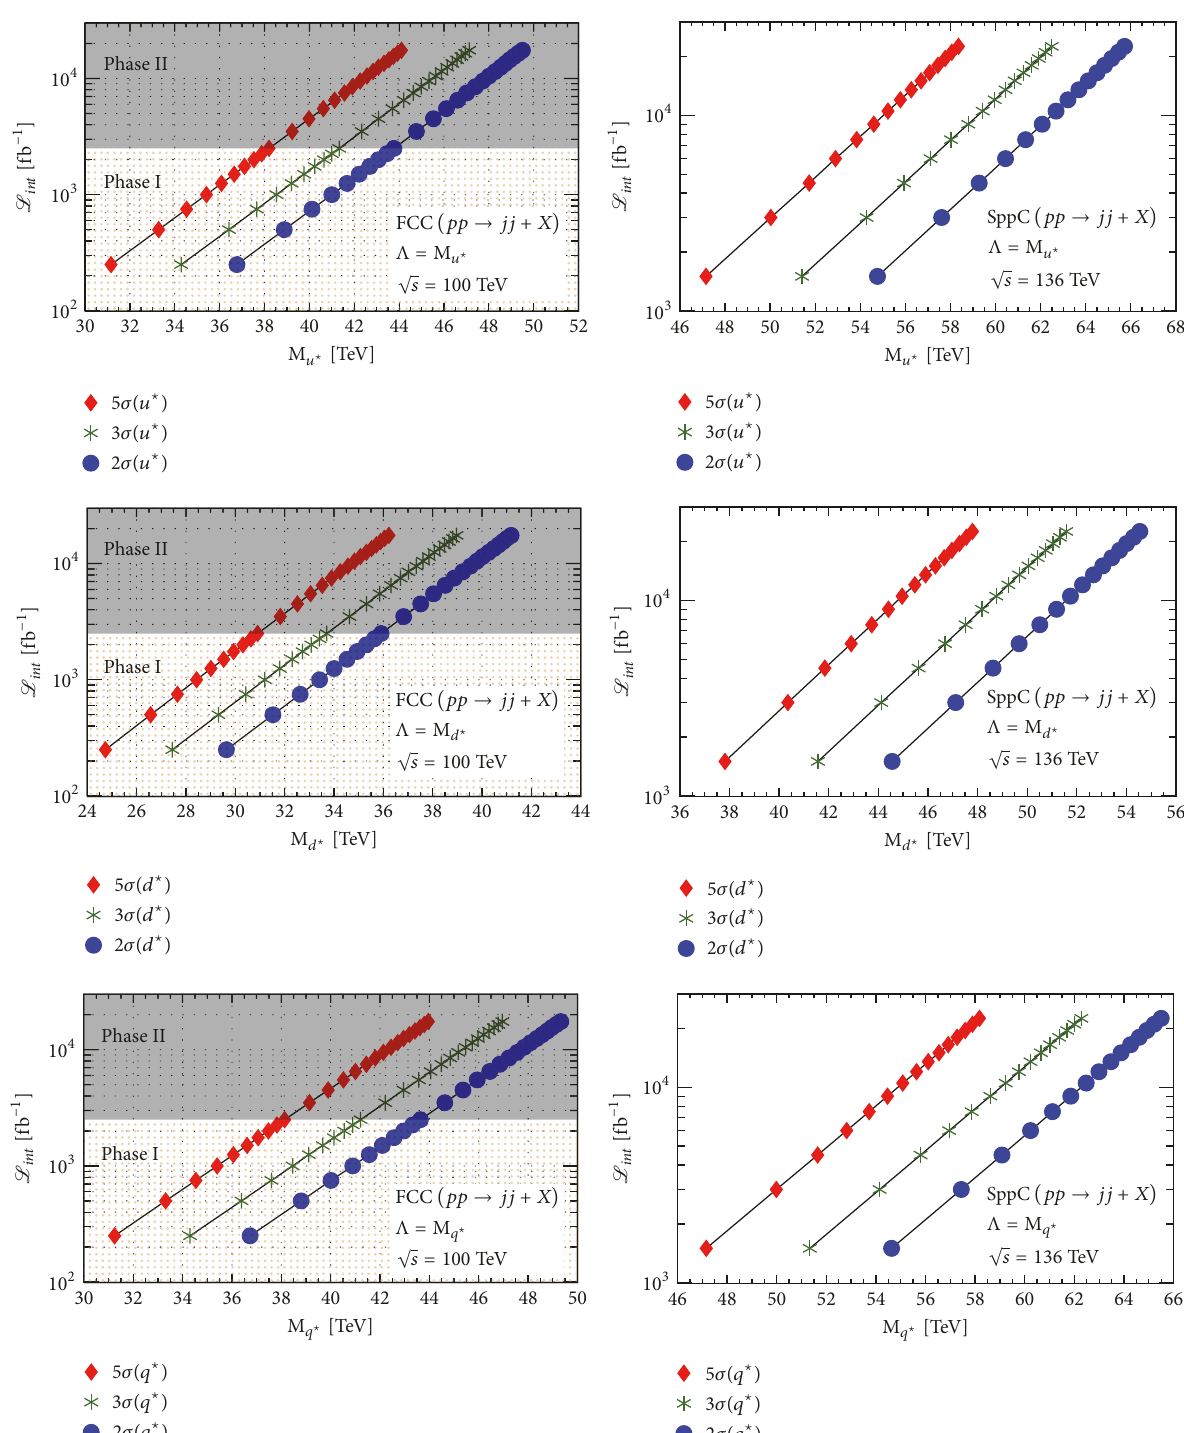
Figure 5: Mass dependence on luminosity at all confidence levels for the FCC (left column) and SppC (right